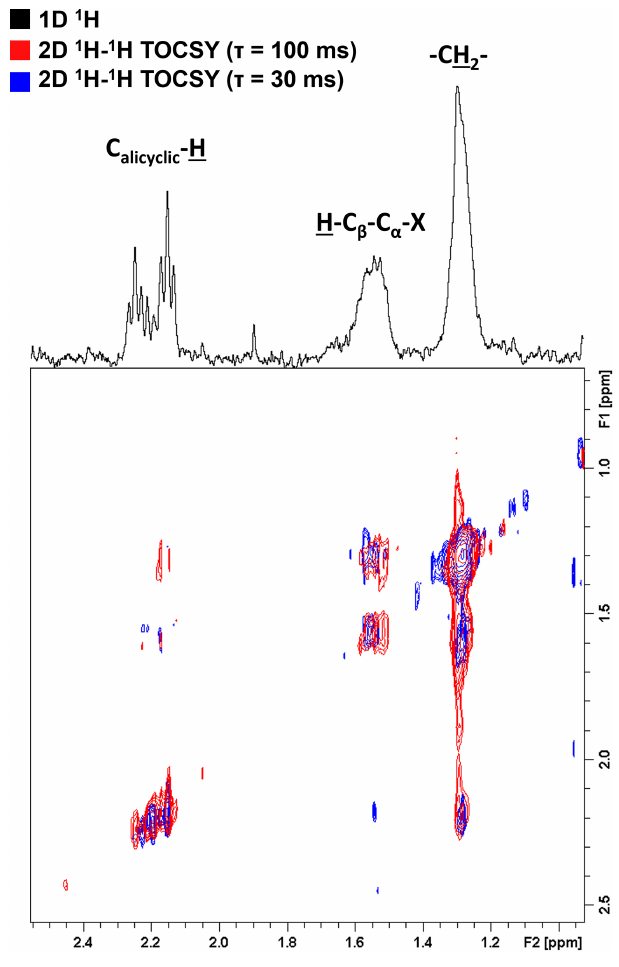
Figure 3. Two-dimensional 1 H– 1 H total correlation spectroscopy (TOCSY) NMR spectra of the bio-incubated Oak 650 Fresh sam- ple. Short- and long-range couplings were allowed to evolve during mixing times ( τ ) of 30 (blue) and 100ms (red), respectively. The 1D 1 H spectrum is shown as a projection on top